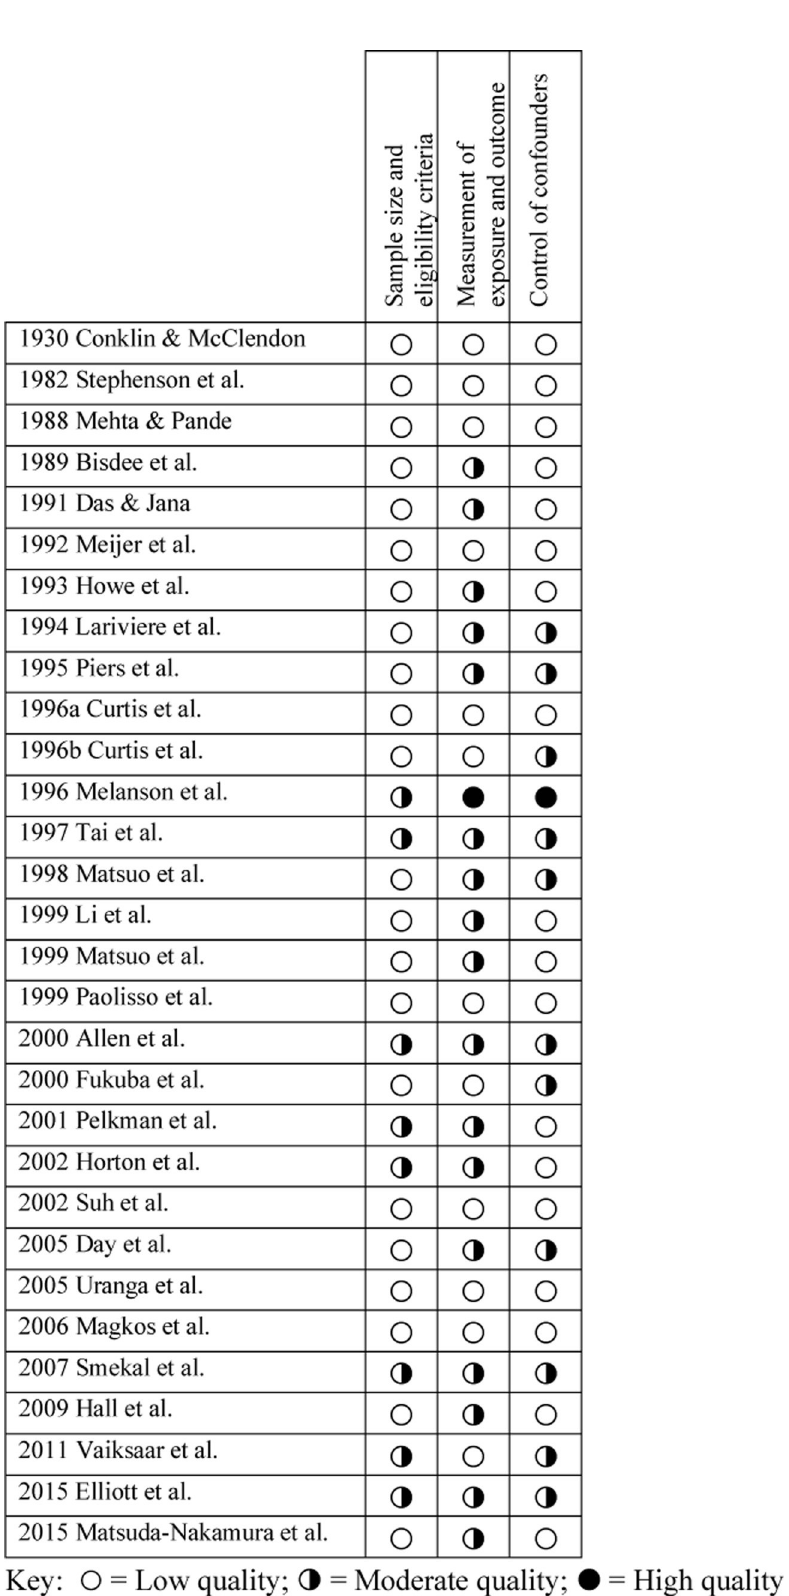
Fig 2. Quality assessment: Risk of bias in individual